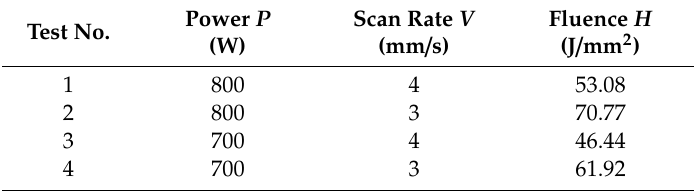
Table 4. Laser treatment parameters for the Cr 3 C 2 –CoNiCrAlY (CRCY) coatings. Test No.